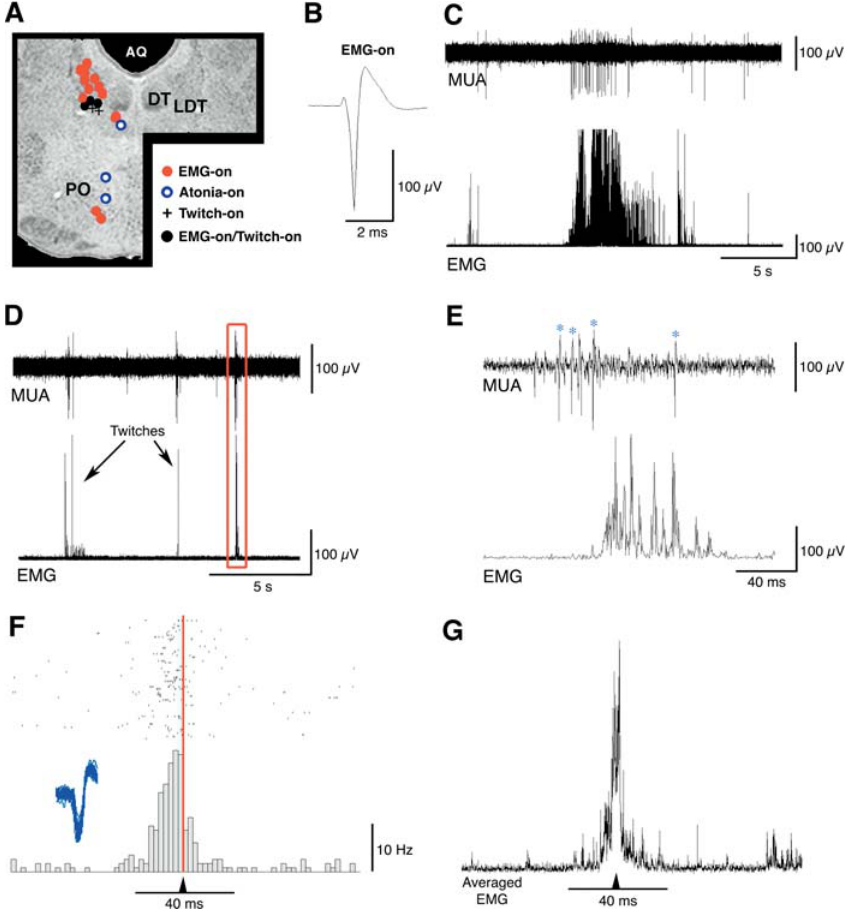
Figure 7. State-Dependent Neuronal Discharges within the Pontine Tegmentum (A) Recording sites of state-dependent neurons reconstructed on a coronal section of the brainstem. Note the predominance of EMG-on neurons. (B) Averaged waveform of a representative EMG-on neuron. (C) Upper trace: multiunit activity. Lower trace: concurrently recorded nuchal EMG. One EMG-on neuron was isolated from the multiunit record; note its tonic discharge during the period of high muscle tone. (D) Upper trace: multiunit activity. Lower trace: concurrently recorded nuchal EMG. (E) Expanded view of the boxed area from (D). Note how multiunit activity precedes the twitch. Asterisks identify a single isolated unit. (F) Peristimulus histogram and raster plot for the twitch-on neuron identified in (E) during a 10-min recording session in a P7 rat (83 total twitches). Inset depicts 55 superimposed action potential waveforms for this unit. This unit’s mean discharge rate peaks 5–10 ms before the twitch (red line). (G) Averaged nuchal EMG for all 83 twitches represented in (F). AQ, cerebral aqueduct; DT, dorsal tegmental nucleus; LDT, laterodorsal tegmental nucleus; PO, nucleus pontis